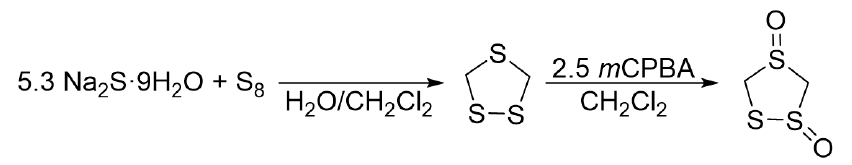
Figure 1. Two step synthesis of